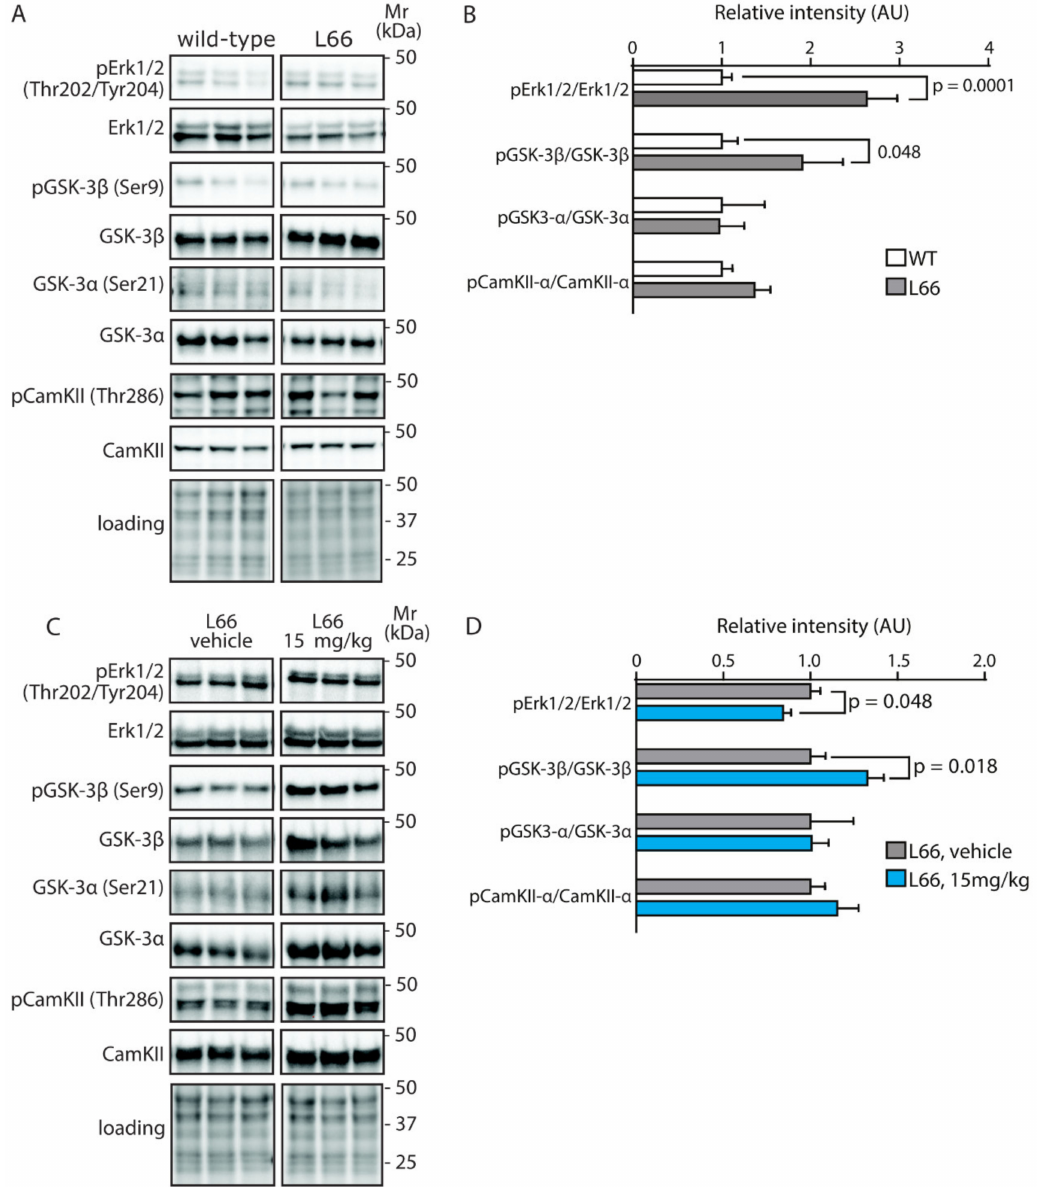
Figure 9. Quantification of ERK, GSK3 and CaMKII activity in mice. Representative immunoblots for ( A ) wild-type and L66 mice and ( C ) L66 mice treated with vehicle or LMTM (15 mg/kg). The proteins were separated by Tris-glycine SDS-PAGE and immuno-detection conducted using the antibodies specified. ( B , D ) Densitometric quantification of the various proteins was normalised to total protein loading and values expressed as group mean ± S.E. Statistical analyses were conducted using unpaired t-test for n = 8–12 ( B ) and n = 11–14 mice ( D ) per group. WT: wild-type. Original blot images are shown in the Supporting